Question: Briefly state, in one sentence, what is plotted here.
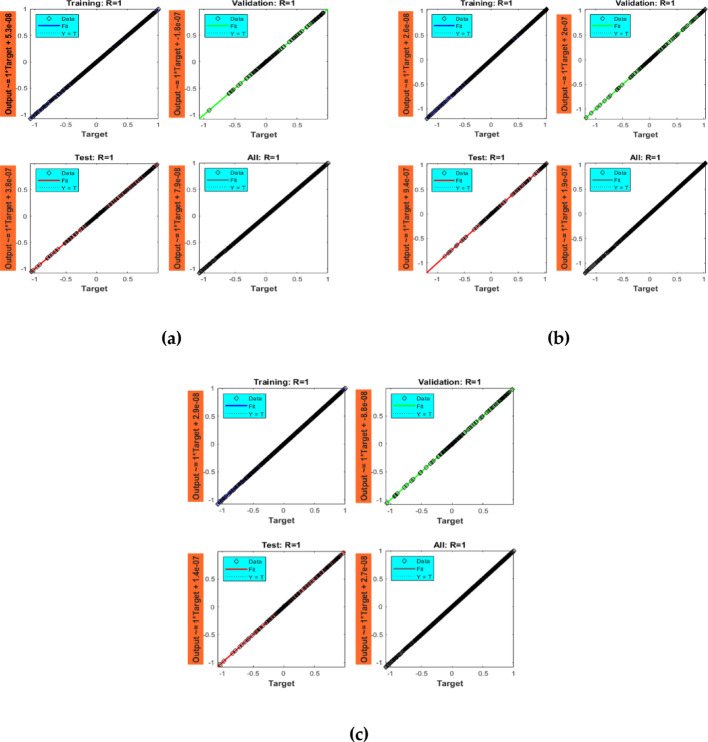
Answer: a-c Regression analysis for ANN design (Scenarios 1–3)